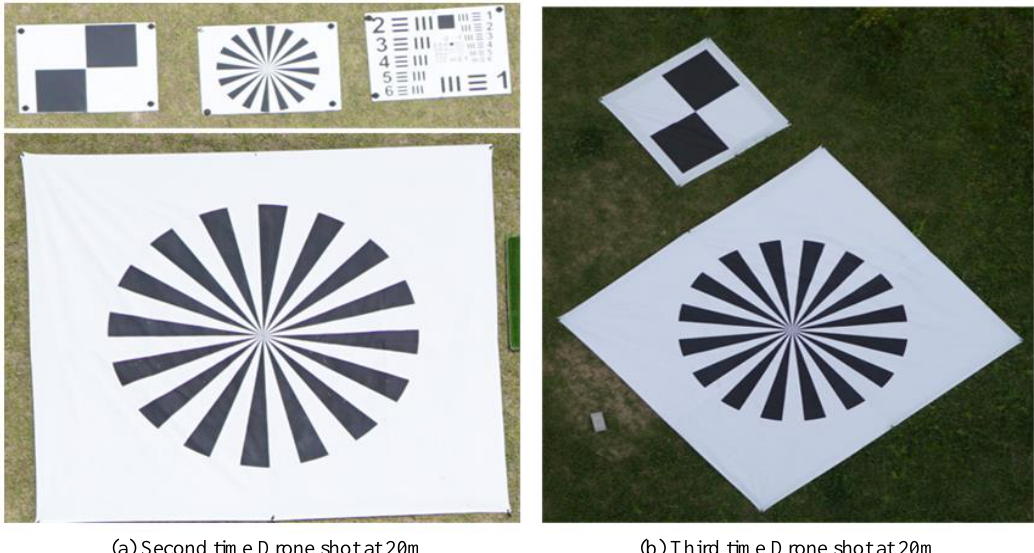
Figure 4. The artificial targets at 20m altitude for edge detection in the first time drone shot